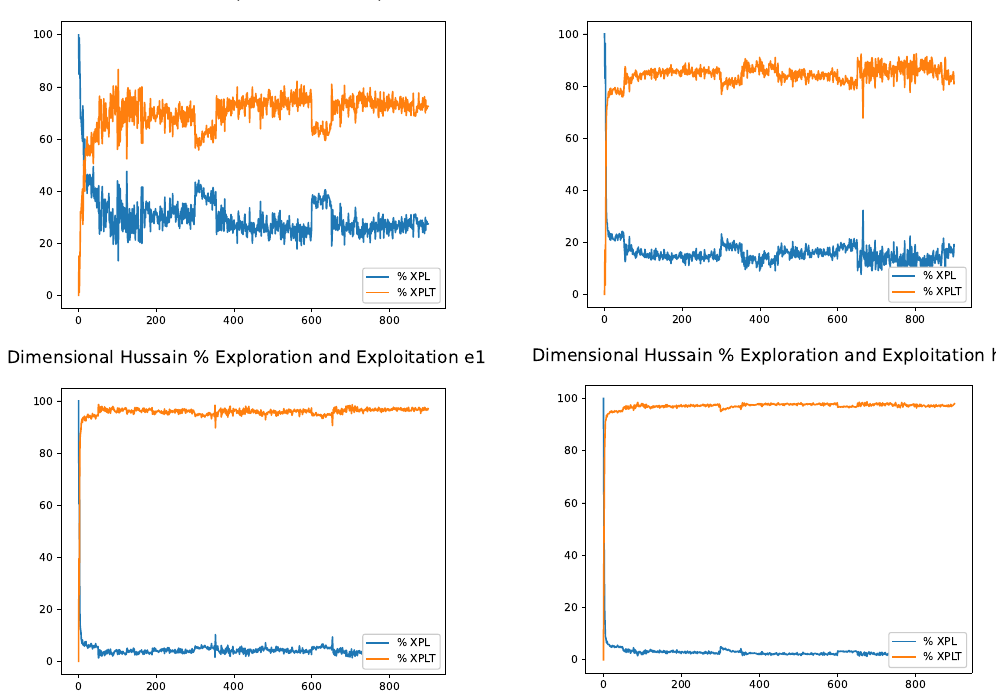
Figure 8. Exploration and exploitation percentage for HPSO. The algorithm shows a mostly exploitative behavior for small and big